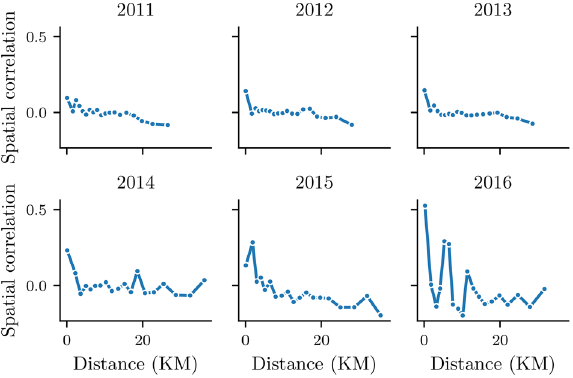
Figure 6. Evolution of the spatial correlation of homicides across neighborhoods and